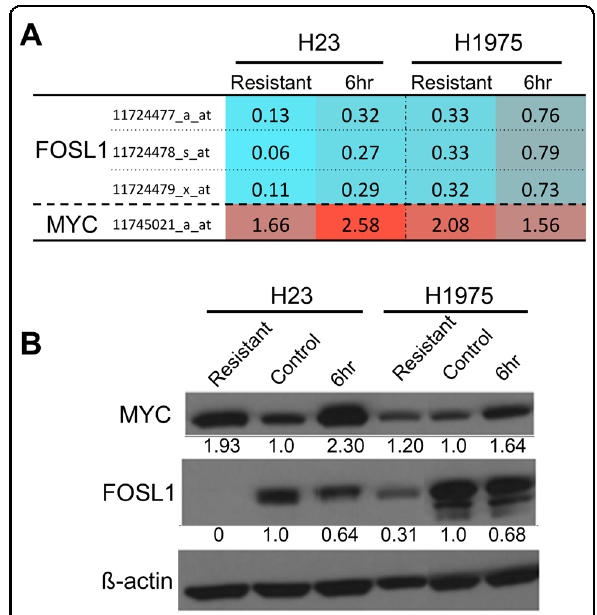
Fig. 2 MYC and FOSL1 transcriptional activation are not involved in JQ1 resistance in LAC. A mRNA expression pro fi les for H23 and H1975 resistant, control and control cells treated with 10 μ M JQ1 for 6 h were generated using Affymetrix arrays as described in the methods section. Resistant lines and 6 h 10 μ M JQ1-treated lines were lysed while being cultured in 10 μ M JQ1 while control lines were lysed, while being culture in regular media. Each condition was pro fi led in triplicate and the resistant and treated control conditions were compared against the control to determine the average fold change in expression. Probes mapping to FOSL1 and MYC are plotted, with the average fold change compared to control indicated. Color scale represents lower (blue) or higher (red) degree of expression compared to control. B Western blots for FOSL1 and MYC in the same cell lines and conditions as in ( A ). The numbers below each band indicate the relative change in protein levels compared to control, calculated using densitometry with beta-actin used to normalize loading. Both mRNA and protein indicate that MYC levels are higher upon JQ1 treatment (6 h), while FOSL1 levels both show initial decrease upon JQ1 treatment and further decrease in both resistant